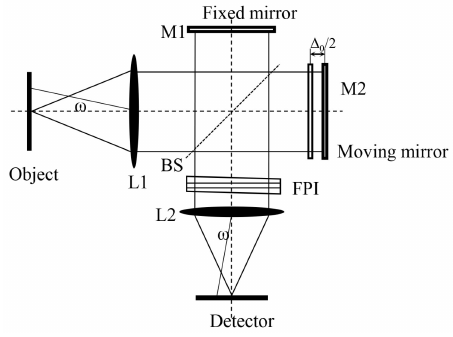
Figure 2. MJI-HI optical system